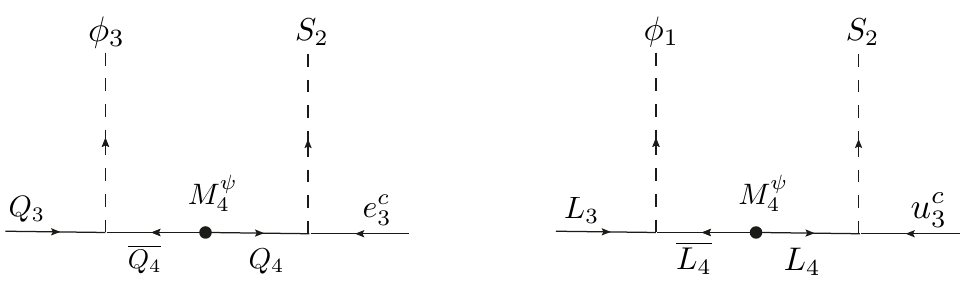
Figure 6 . Diagrams which lead to the S 2 leptoquark effective couplings relevant for R